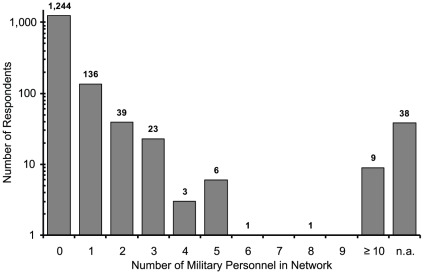
Military Personnel.